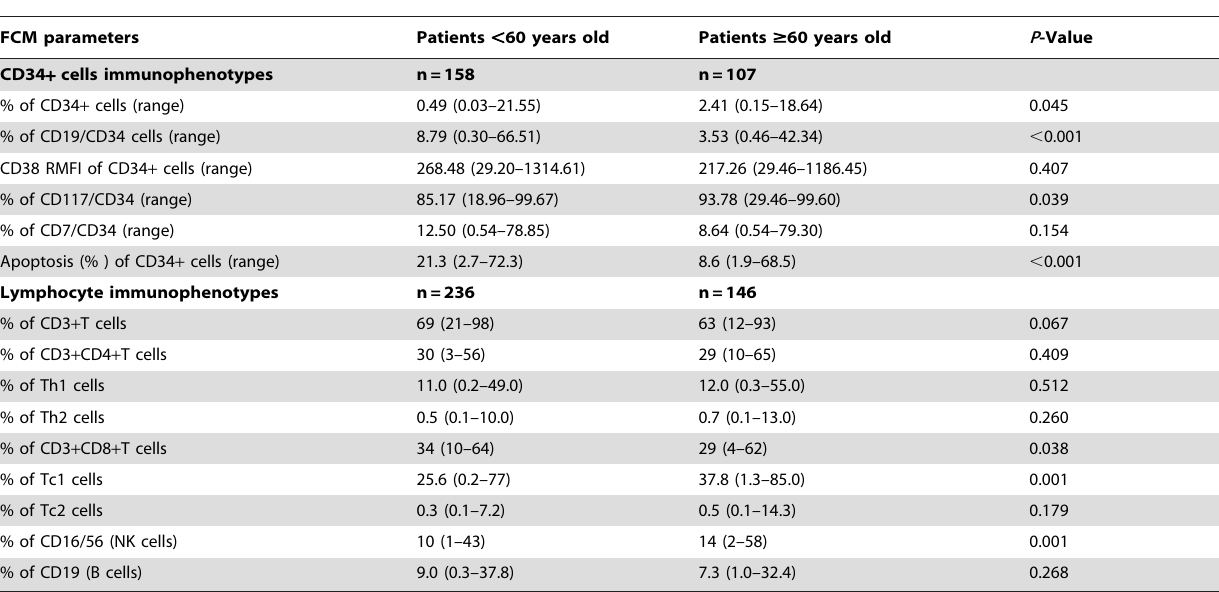
Table 2. FCM analysis of CD34 + cells and lymphocytes in both groups of MDS